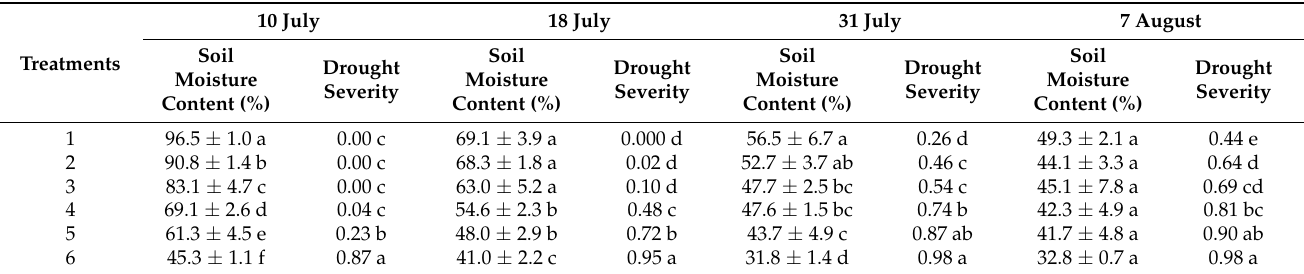
Table 1. The relative soil moisture (RSM) at 0–30cm depth and drought severity of each treatment.